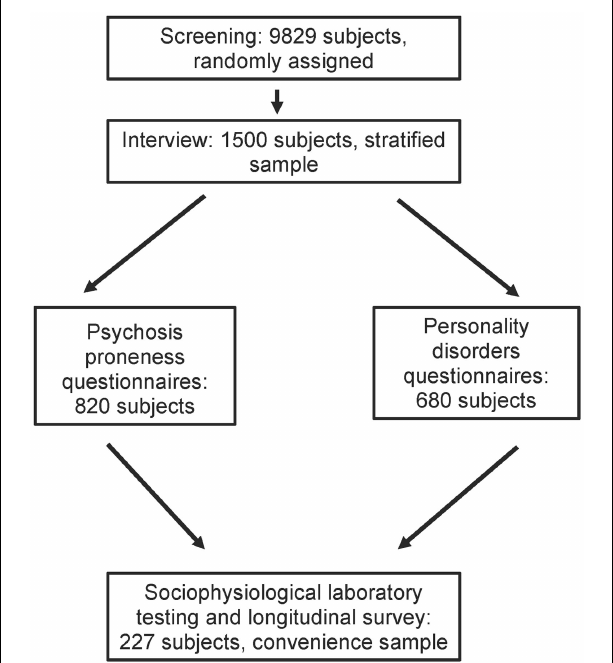
FIGURE 1 | The sampling procedure of the ZInEP epidemiology survey